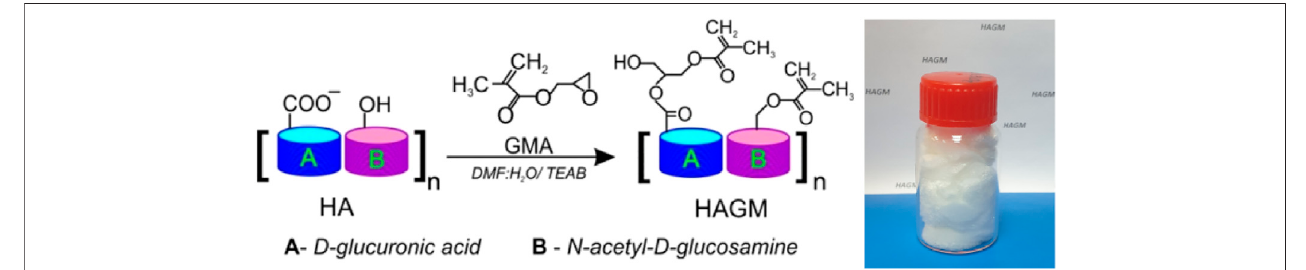
FIGURE2|(A) Absorptionand luminescencespectraofFMN. (B) ExtrusionofthehydrogelinkintotheFMN/TEOHAwatersolutionexcitedby450 nmlight.Laser excitation visualized as wide illuminated trace. (C) Plot of DPPH photobleaching vs. TEOHA concentration in 0.066 mM FMN solution. (D) Dynamic viscosity of inks depending on DS of HAGM. Dots indicate experimental data; solid curve represents least squares fi tting. All measurements have been performed at least in triplicate, data are presented as mean value, and SD did not exceed 10%.